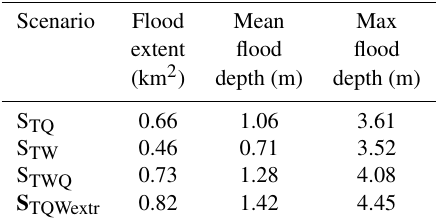
Table E1. Flood extents and maximum and mean flood depths of all